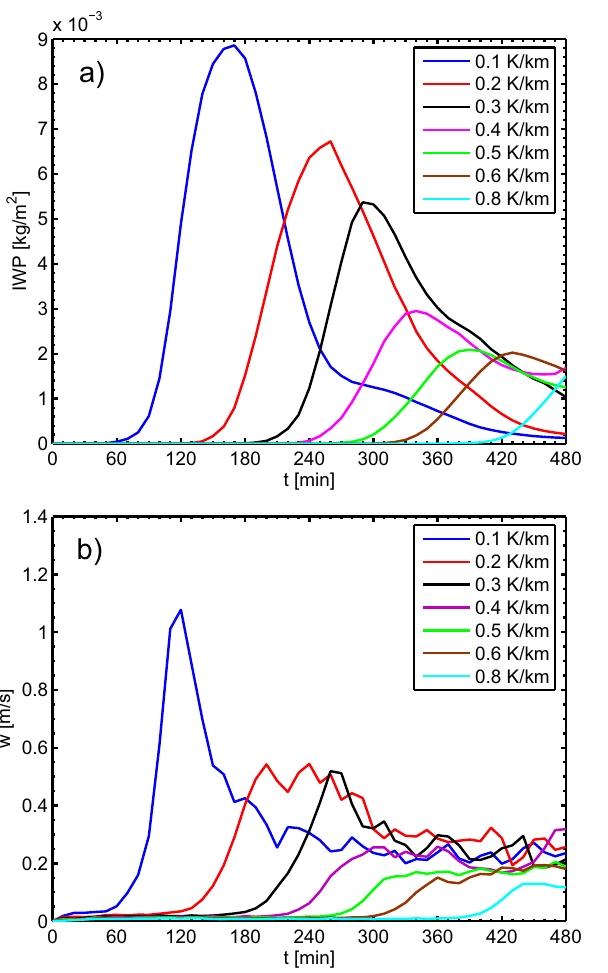
Fig. 7. (a) Histogram of vertical velocity for all time steps (for 3 dif- ferent thermal stratifications ∂θ/∂z = 0 . 1 / 0 . 4 / 0 . 8 K / km). The red line represents the reference case; (b) Histogram of number con- centration for all time steps (for 3 different thermal stratifications ∂θ/∂z = 0 . 1 / 0 . 4 / 0 . 8 K / km. The red line represents the reference